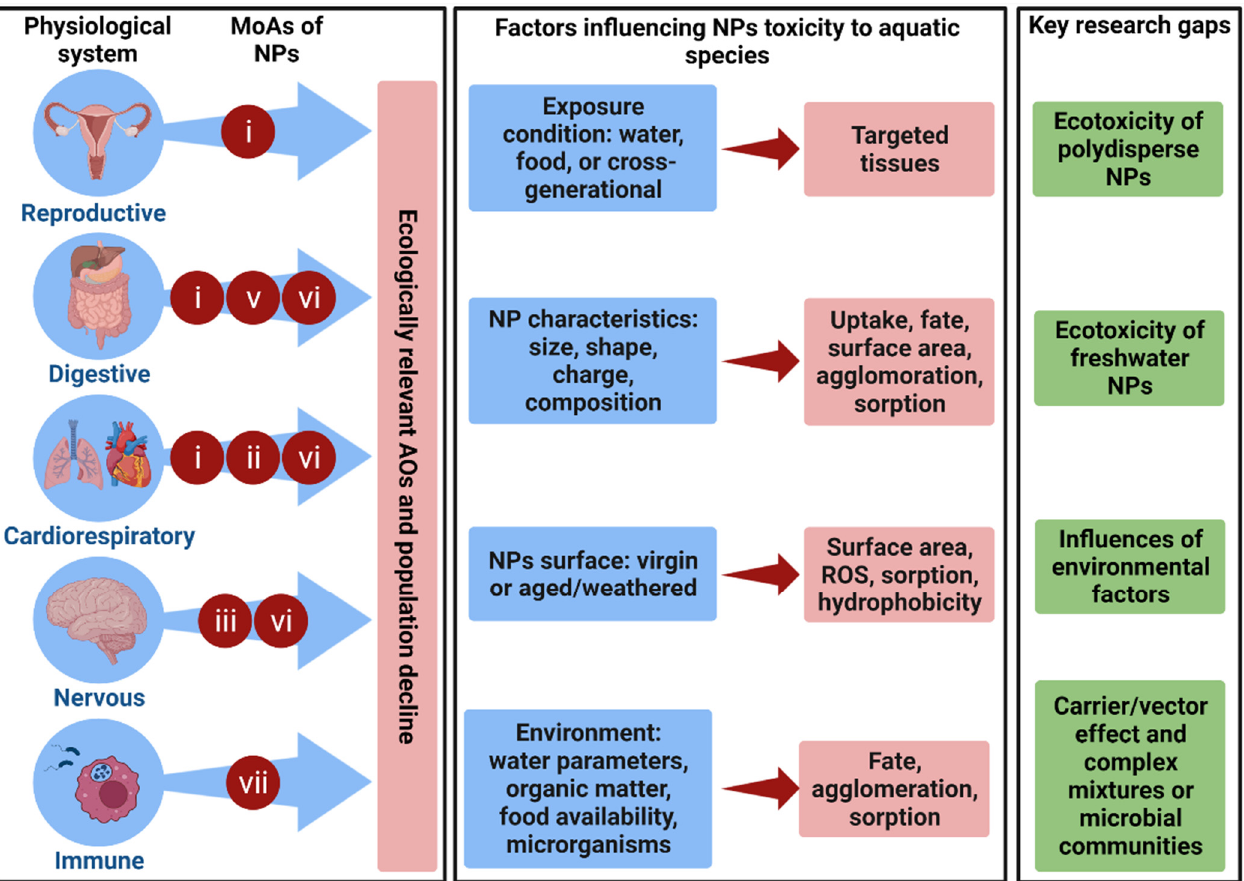
Figure 3. Summary of the effects of nanoplastics (NPs) on aquatic species, their toxicity in re- sponse to the interactions with organismal and environmental parameters, and main research gaps in the field. ( Left panel ): NPs may accumulate in tissues related to key physiological systems, triggering a cascade of molecular, biochemical, cellular, and physiological processes that can explain many of the observed or predicted ecologically relevant adverse outcomes of NPs. This chain of events may be broken down into seven modes of action (MoAs, please see Section 3.2 for further clarification): (i) organismal fitness, (ii) circulatory and respiratory systems, (iii) behavioral, sensory, and neuromuscular function, (iv) alimentary and excretory systems, (v) microbiome, (vi) metabolism, and (vii) immune system [42]. ( Center panel ): differences in NPs’ properties and exposure pathways, whether caused by environmental conditions or not, might result in altered behavior, fate, uptake, sorption to pollutants or microorganisms, hydrophobicity, or the formation of reactive oxygen species (ROS). ( Right panel ): examples of research gaps that may indicate future directions to consider in the field of NPs ecotoxicity (please see Section 4 for clarification). Organs are shown as corresponding to mammalian species for purposes of